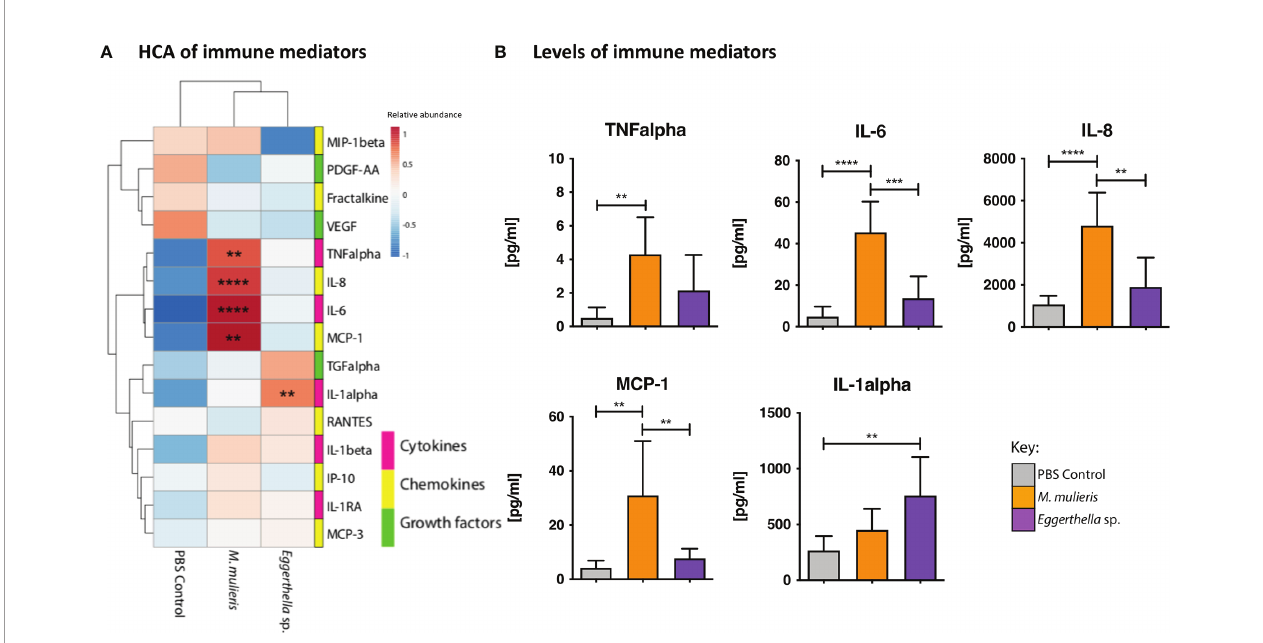
FIGURE 2 | M. mulieris signi fi cantly elevated production of in fl ammatory cytokines and chemokines compared to Eggerthella sp. and PBS mock-infected controls in 3-D cervical aggregates. (A) Hierarchical clustering analysis (HCA) of cytokine, chemokine, and growth factor pro fi les secreted by 3-D cervical cells in response to infection with Eggerthella sp. MVA1 or M. mulieris UPII-28I. The data was log-transformed and Pareto-scaled prior to clustering. HCA was performed using Euclidean distance measures and average linkage clustering algorithms. (B) Bio-Plex analysis of cytokines, chemokines and growth factors secreted by 3-D human cervical cells infected with M. mulieris UPII-28I and Eggerthella sp. MVA1 for 24h in anaerobic conditions. TNF- a , IL-6, IL-8 and MCP-1 were all signi fi cantly elevated by M. mulieris UPII-28I, whilst Eggerthella sp. MVA1 signi fi cantly increased expression of IL-1 a . Statistical signi fi cance was determined by one-way ANOVA and Bonferroni post-hoc multiple comparisons. **, p <0.01; *** , p <0.001; ****, p